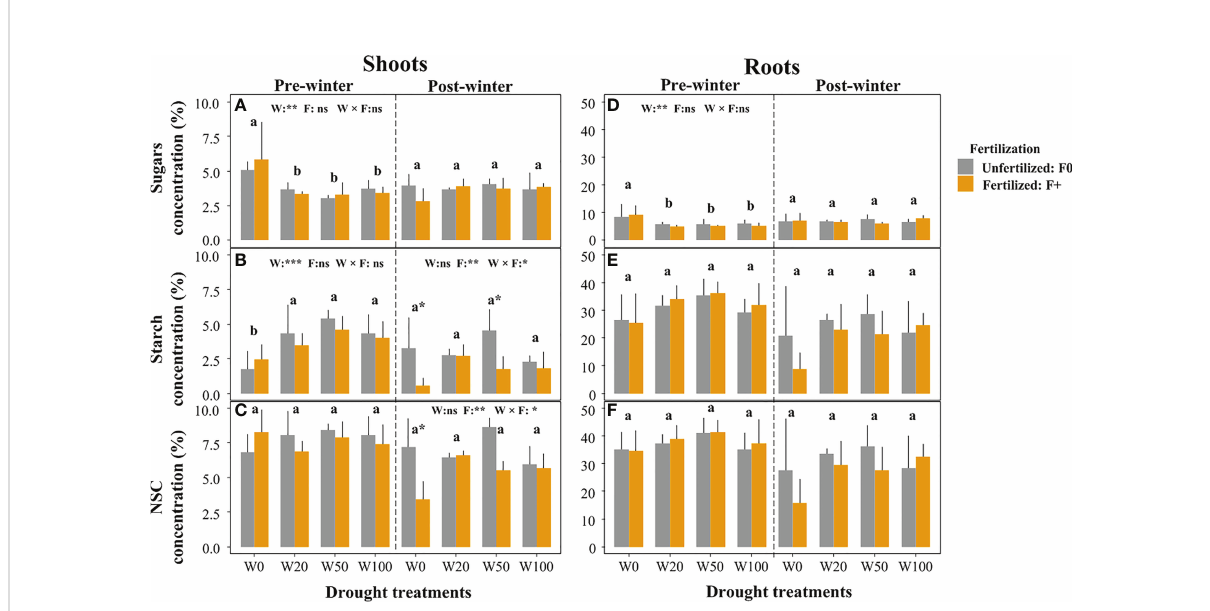
FIGURE 2 Effectsofdroughtandfertilizationonnon-structuralcarbohydrates(NSC)inshootsandrootsofdownyoaksatprewinter(November,2016)andpostwinter (March,2017). (A) sugarsinshoots, (B) starchinshoots, (C) thetotalNSC(sugars+starch)inshoots(leftpanelforpre-winter,andrightpanelforpost-winter); (D) sugarsinroots, (E) starchinroots, (F) thetotalNSC(sugars+starch)inroots.Thedroughttreatmentscontainfourlevels:W100(soilwatercapacity,~25%VWC), W50,W20andW0(soilwiltingpoint,~6%VWC),W50andW20correspondingtoapprox.50%and20% fi eldwatercapacity,respectively.Resultsoftwo-way ANOVAwithdrought(W)andfertilization(F)(theirinteractioneffectwasalsoconsidered)aregivenonthemiddletopofsub fi gures,usingns(non-signi fi cant), *p(<0.05),**(p<0.01),or***p(<0.001)ifsigni fi canteffectwasdetected.Differentlower-caselettersrepresentsigni fi cantdifferencesinmeansamong droughttreatmentstestedwithaTukey post-hoc test,asterisks(onthebar)showsigni fi